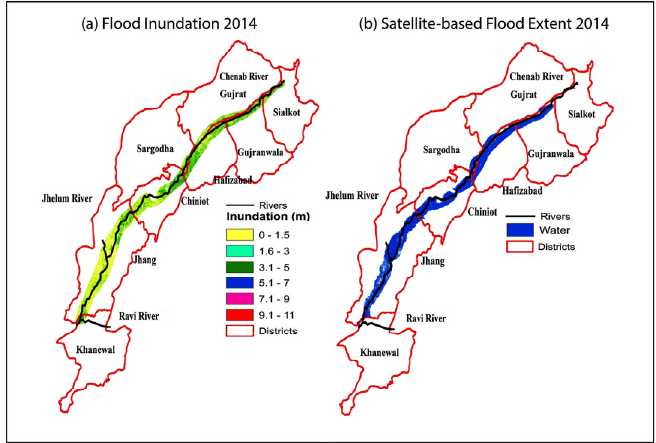
Figure 7. ( a , b ) Simulated and observed inundation extents for the 2014 flood. Flood hazard maps indicate flood risk areas and provide the most advanced flood probability zones, which help people to decide about their investment in the floodplains.